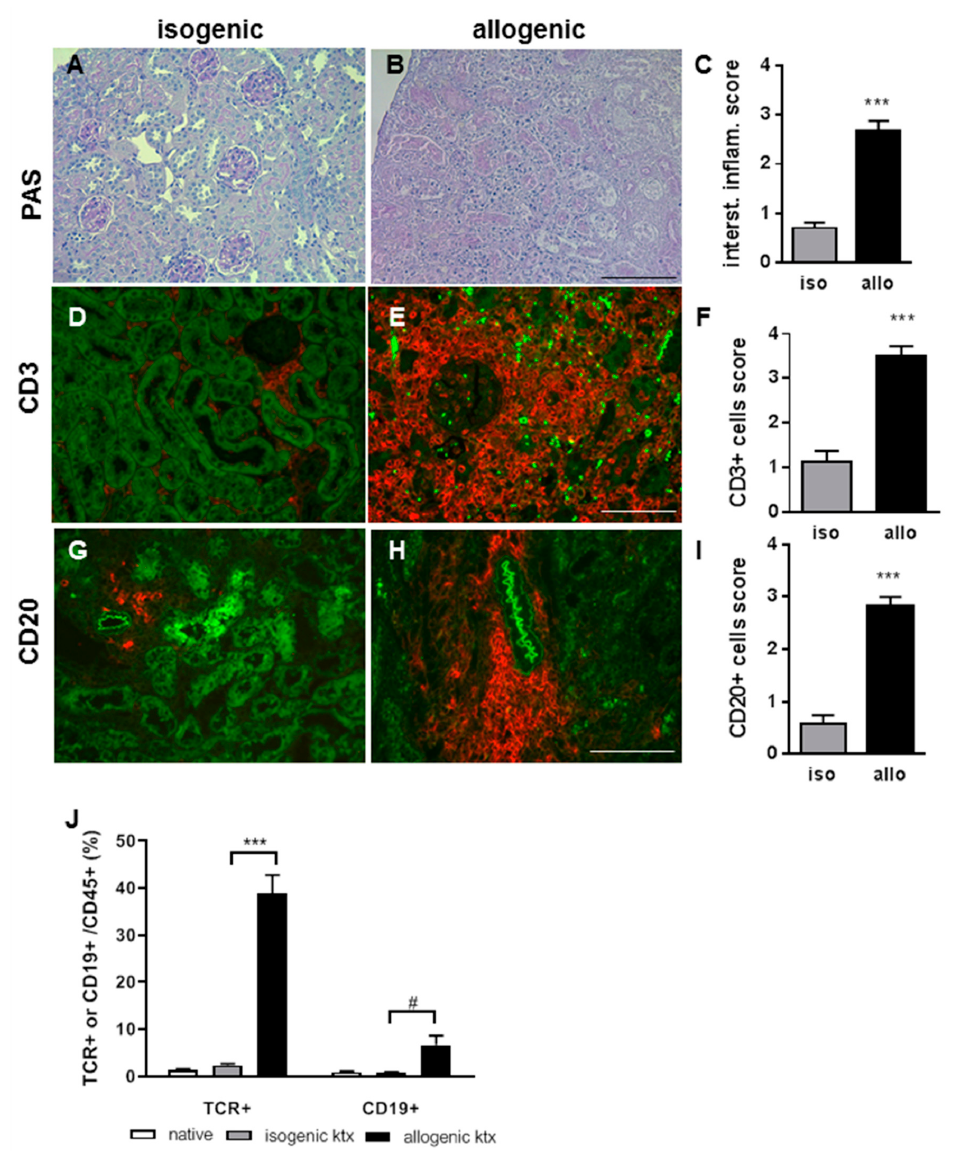
Figure 2. At three weeks after ktx, renal allograft rejection was characterized by severe inflammation and Banff 1A, and higher rejection grades in comparison to isogenic grafts without inflammation ( A – C , representative PAS stains, bar: 200µm). The majority of infiltration cells were CD3+ T-lymphocytes, which formed interstitial dense infiltrates and clustered around vessels and glomeruli ( D – F , bar: 200µm). CD20+ nodular B-cell clusters were identified with much higher cell count in allografts compared to isografts ( G – I , bar: 100µm). Flow cytometry of the infiltrating leukocytes of the grafts showed significantly enhanced proportion of CD3+ T-lymphocytes in allografts and also enhanced CD20+ B-lymphocytes ( J , *** p < 0.001, # p < 0.05).